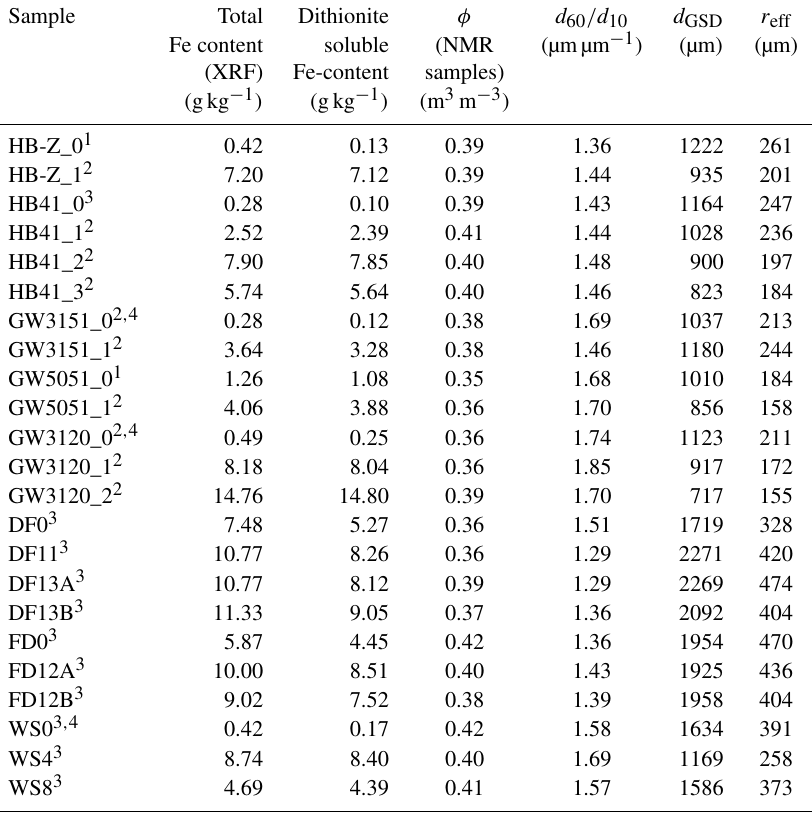
Table 2. List of samples with artificial and natural iron clogging (Set B).